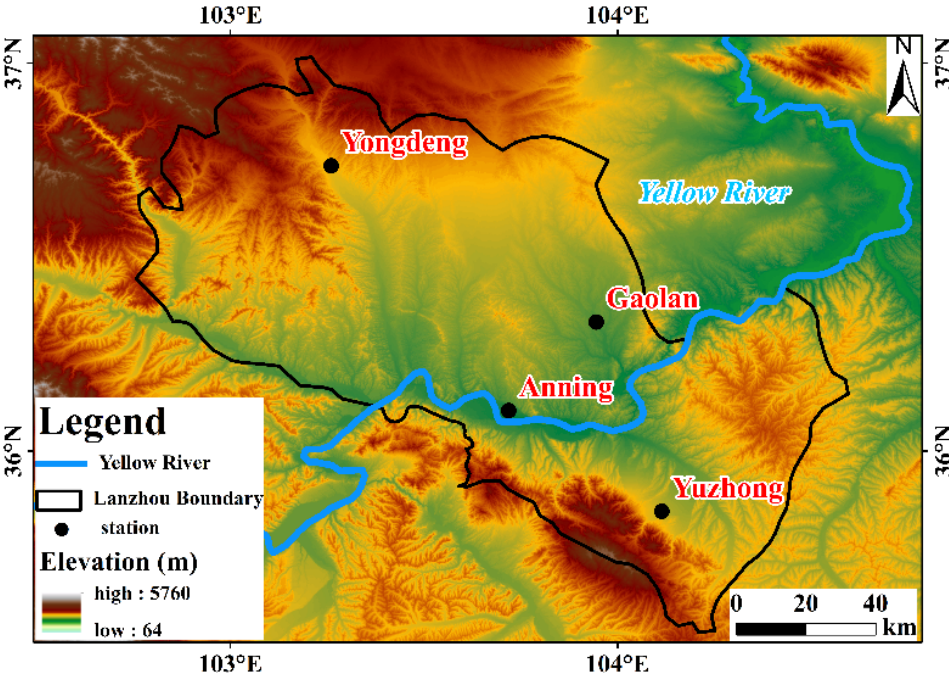
Figure 1. Spatial distribution of sampling stations (Anning, Yuzhong, Gaolan and Yongdeng) in Lanzhou, China. The black polygon denotes the administrative boundary of Lanzhou city. The blue curve denotes the Yellow River.